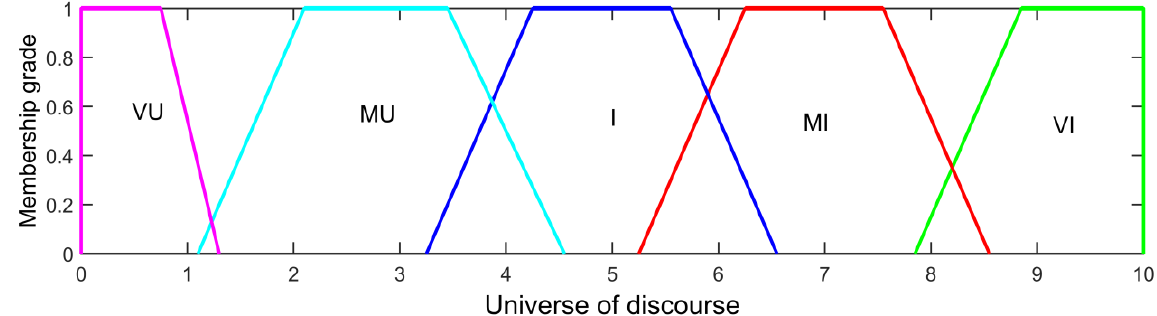
Figure 5. Linguistic words describing the weights of indicators and their T1 FSs.